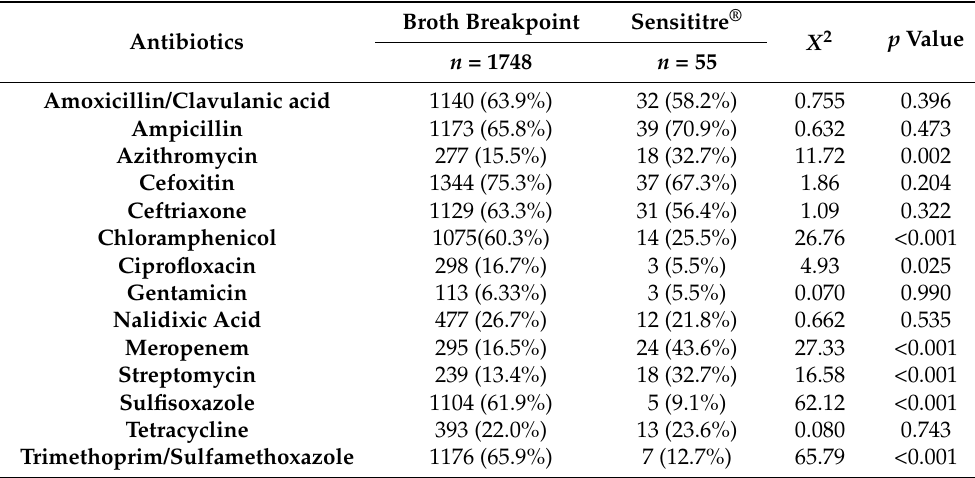
Table 2. Effects of antimicrobial susceptibility testing methodology on resistance ratios of poultry Salmonella collected via direct plating in trial